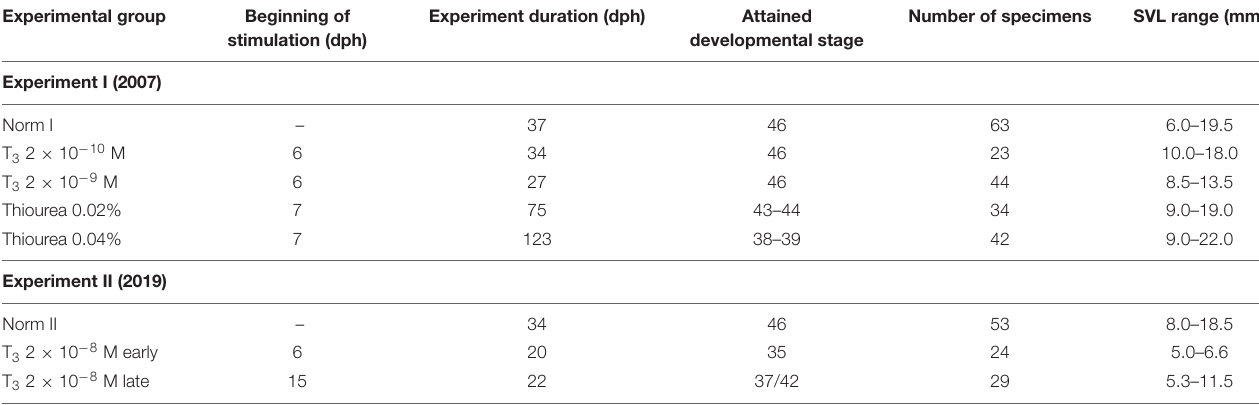
TABLE 1 | Specimens of Bombina variegata examined in the experimental study. Experimental group Beginning of stimulation